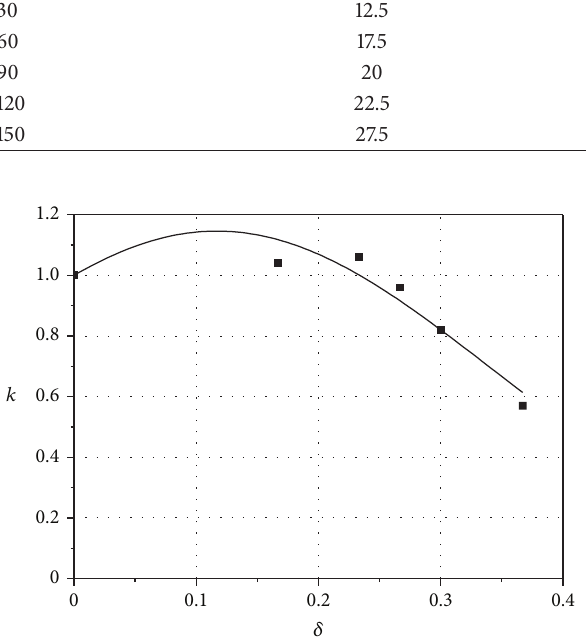
Figure 9: Fitting curve of corrosion resistance coefficient.